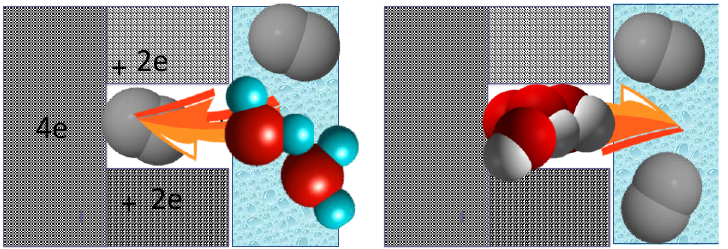
Figure 11. Schematic view of the involvement of ultramicropores/O 2 adsorption in ORR. Reprinted with permission from Reference [57]. Copyright 2019, The Royal Society of Chemistry.